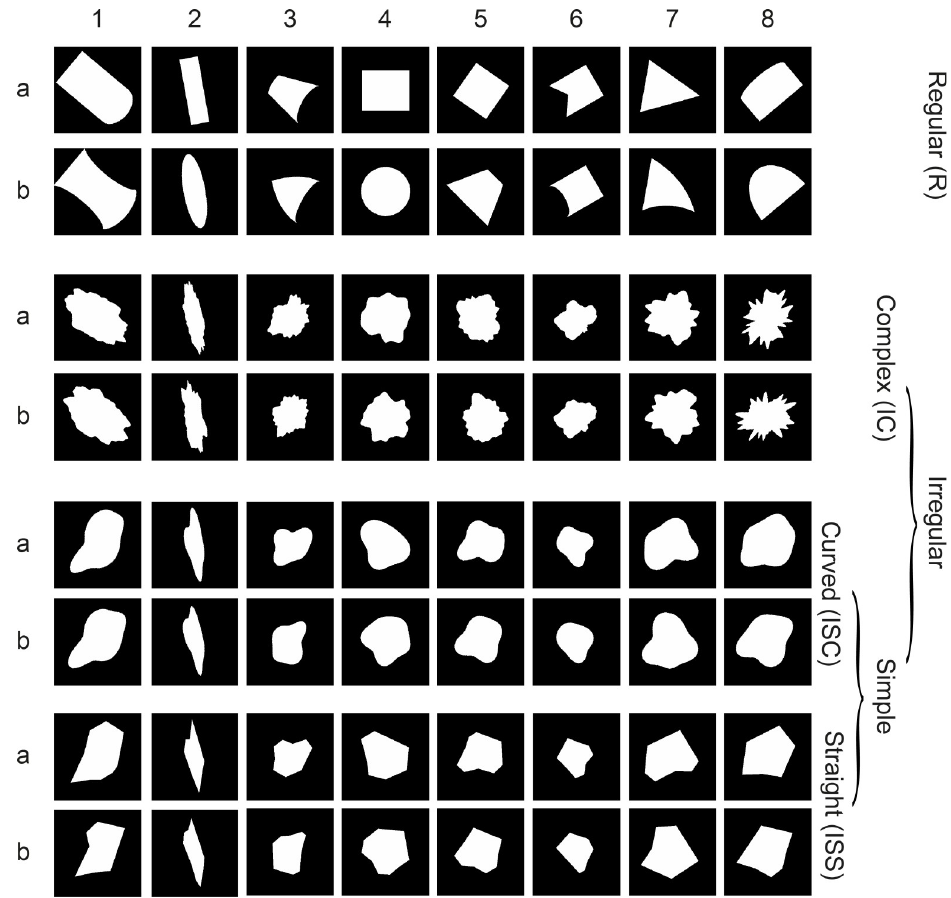
Fig 1. Shape set. One group of Regular (R) and three groups of Irregular shapes: Irregular Complex (IC), Irregular Simple Curved (ISC) and Irregular Simple Straight (ISS). A group of 16 shapes corresponds to two consecutive rows (labeled a,b) and the group names are depicted in the tree graph on the right. The 8 pairs (a,b) of each group are defined by the numbers on top of the figure (1,2, ... 8).